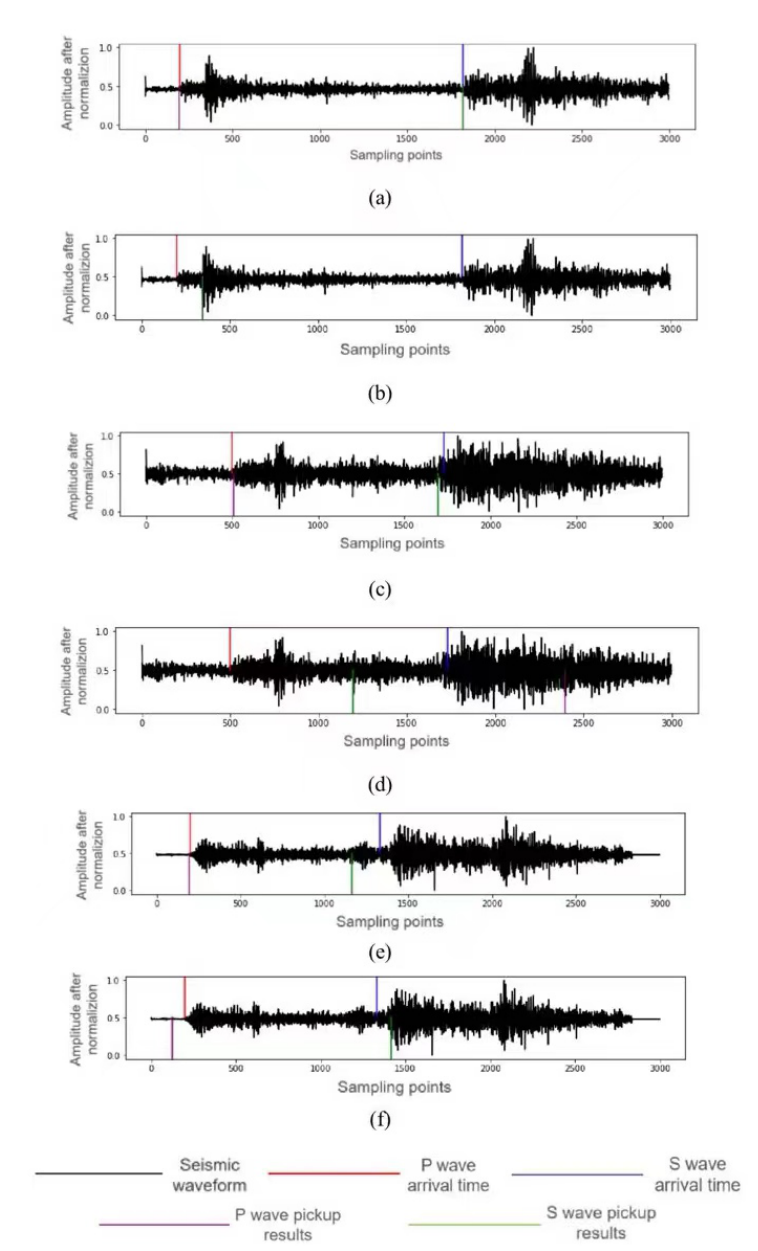
Figure 12. Examples of detection success and failures: ( a , c , e ) represent the detection results from our S-TCN model; ( b , d , f ) represent the detection results from the